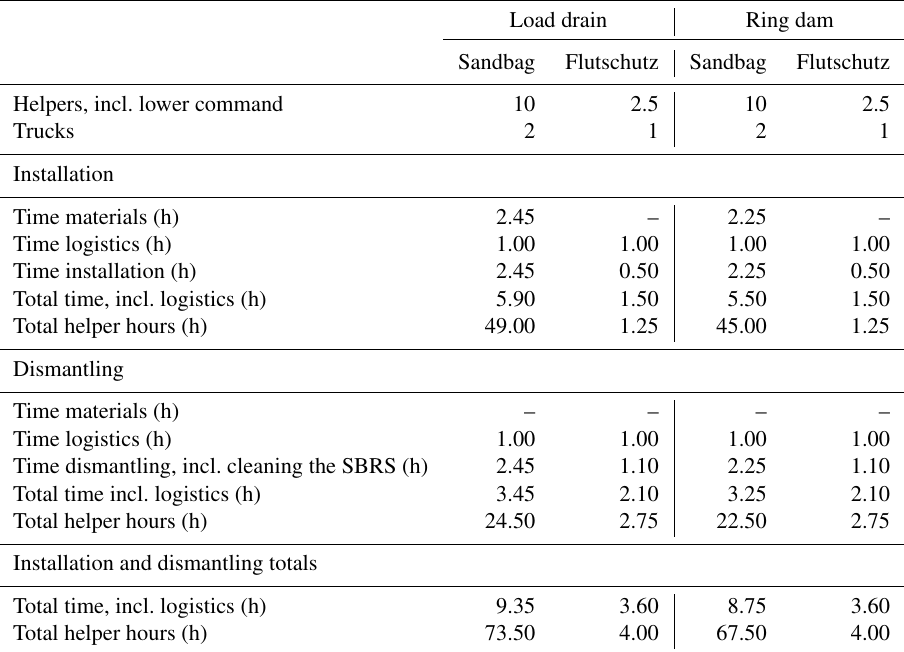
Table 8. Comparison of time, helpers and logistics requirements for the installation and dismantling of sandbag systems and SBRSs – load drain (case 2) and ring dam (case